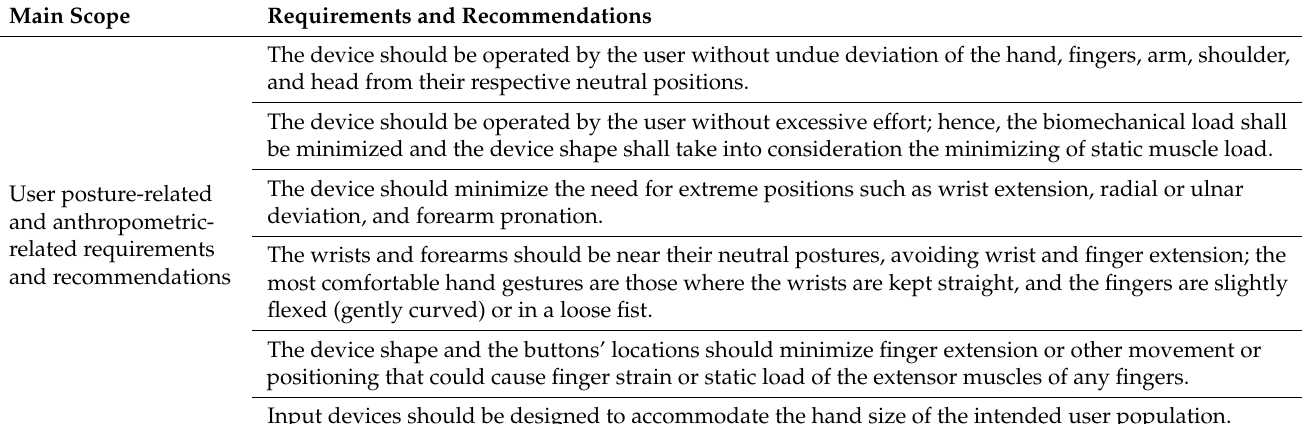
Table 1. Design specification